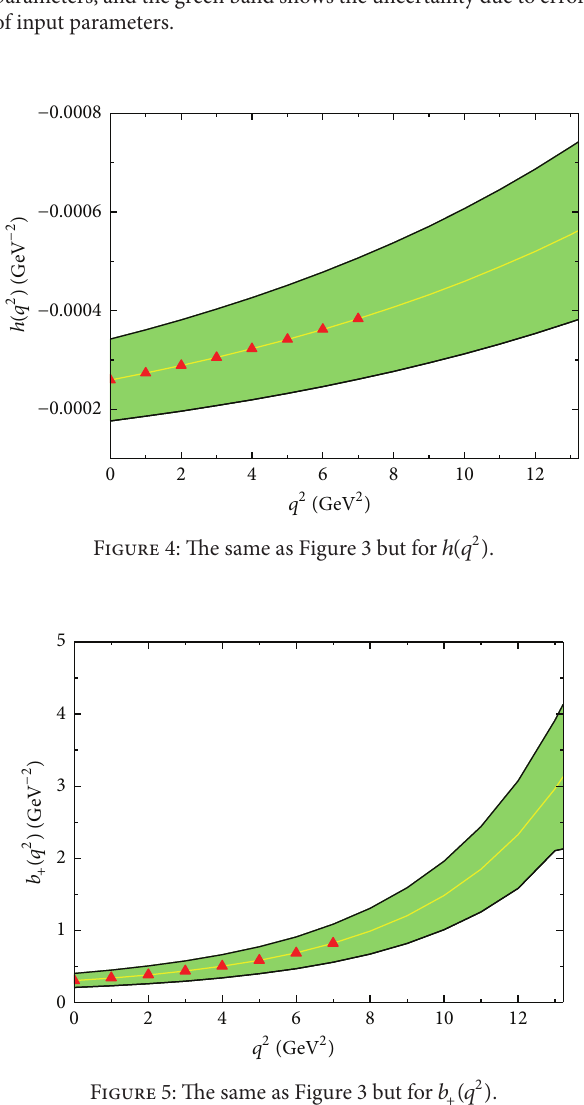
Figure 5: The same as Figure 3 but for 𝑏 + (𝑞 2 ) .